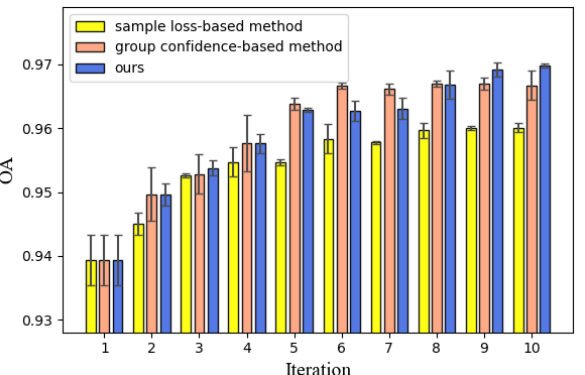
Figure 11. The result accuracy and the variance of two models under three settings on River